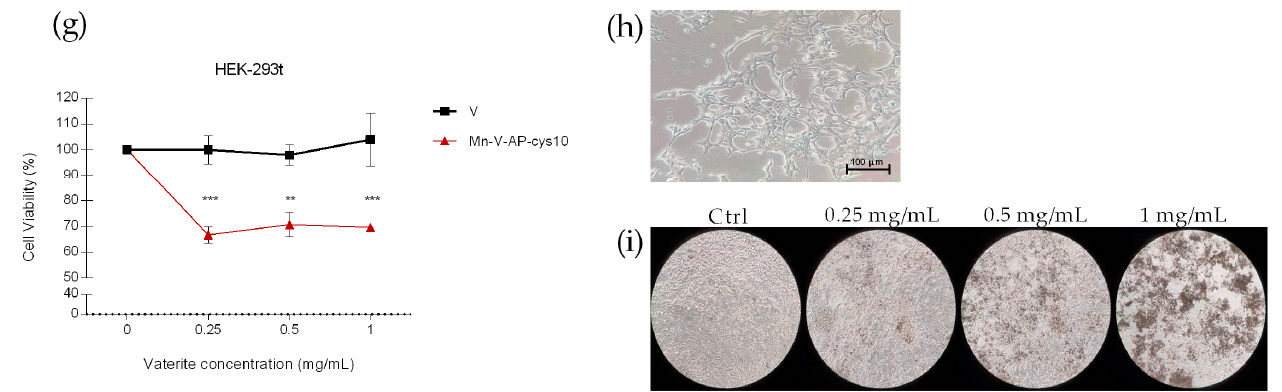
Figure 7. Cell viability at different concentrations (0, 0.25, 0.5, and 1 mg/mL) and saturation effect produced by precipitation of the materials. ( a ) Dose response in CT2A cells; ( b ) CT2A line cells in normal growth; ( c ) CT2A cells micrographies with different concentrations of vaterite. ( d ) Dose response in SKBR3 cells; ( e ) SKBR3 line cells in normal growth; ( f ) SKBR3 cells micrographies with different concentrations of vaterite. ( g ) Dose response in 293t cells; ( h ) 293t line cells in normal growth; ( i ) 293t cells micrographies with different concentrations of vaterite. The significant differences are indicated as **** p < 0.0001, *** p < 0.001, ** p < 0.01, * p < 0.05.